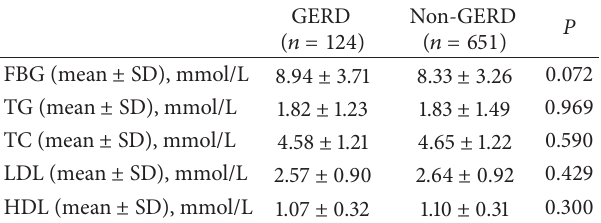
Table 2: Comparison of laboratory data between GERD group and non-GERD